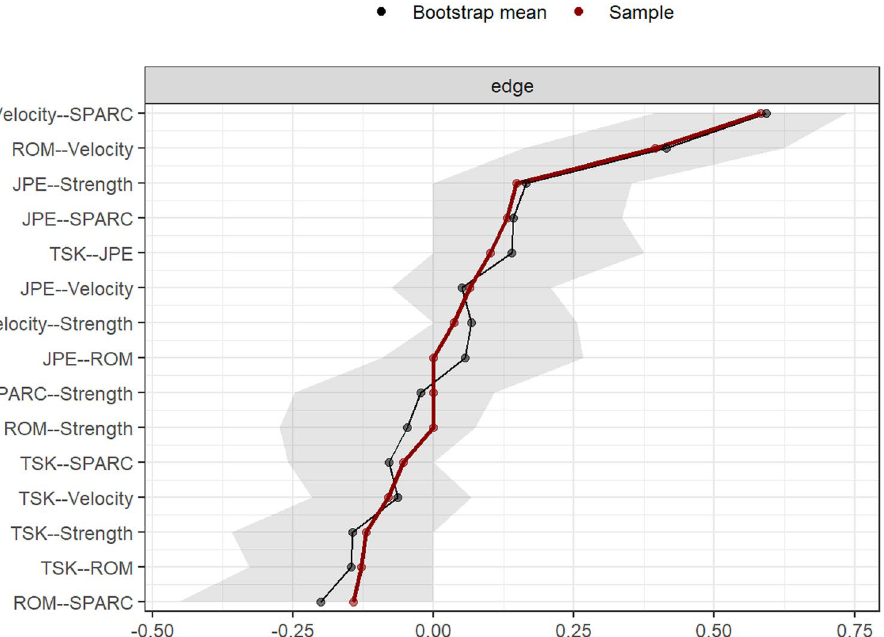
Figure 2. Edge weights (based on original and bootstrapped samples) along with their variability (bootstrapped confidence intervals, grey area) are reported. SPARC Spectral arc length, TSK Tampa scale for kinesiophobia, ROM Range of motion.